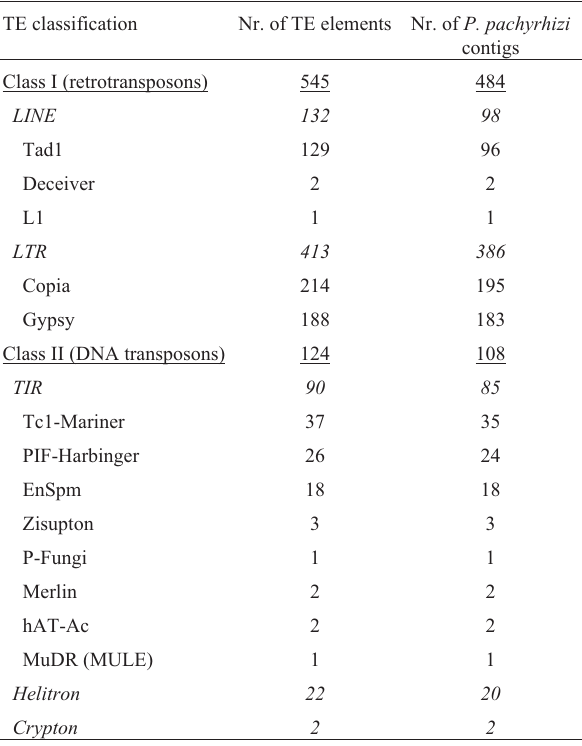
Table 4 - Transcriptionally active transposable elements in P. pachyrhizi transcriptome.